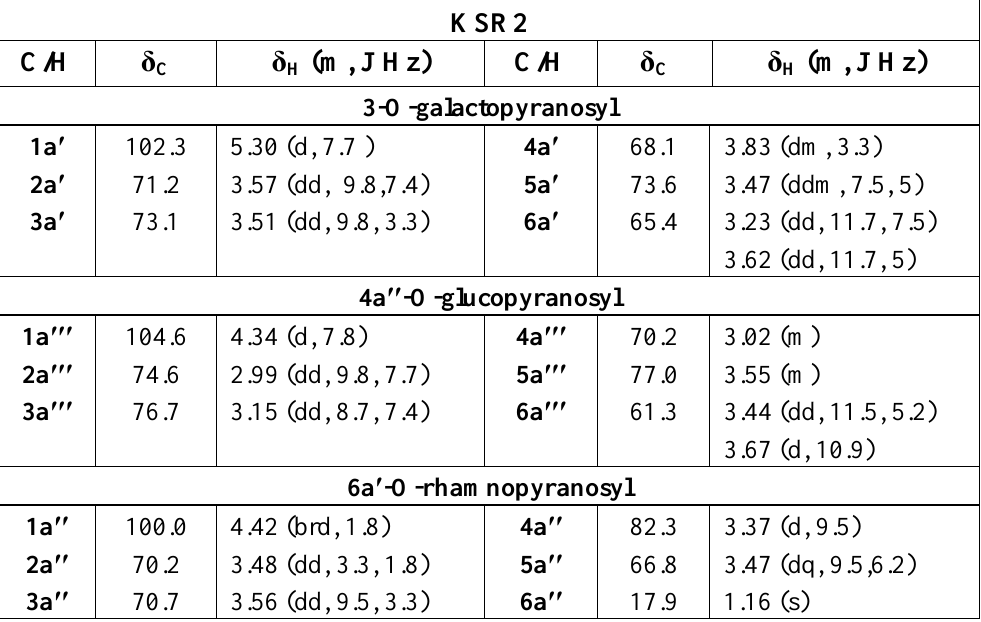
Table 3 . 13 C- and 1 H-NMR spectral data for side groups attached at the C-3 position in compounds KSR2 , KSR3 and KSR4 * (D